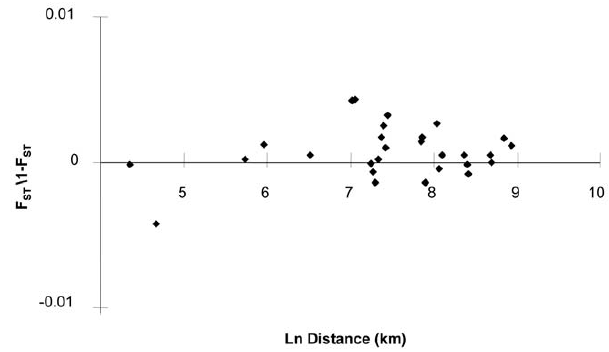
Figure 2. Isolation by distance based on microsatellites in northern fur seals including the relationship between genetic distance, pairwise comparisons of rookeries and the natural log of the geographic distance between the rookery pairs.